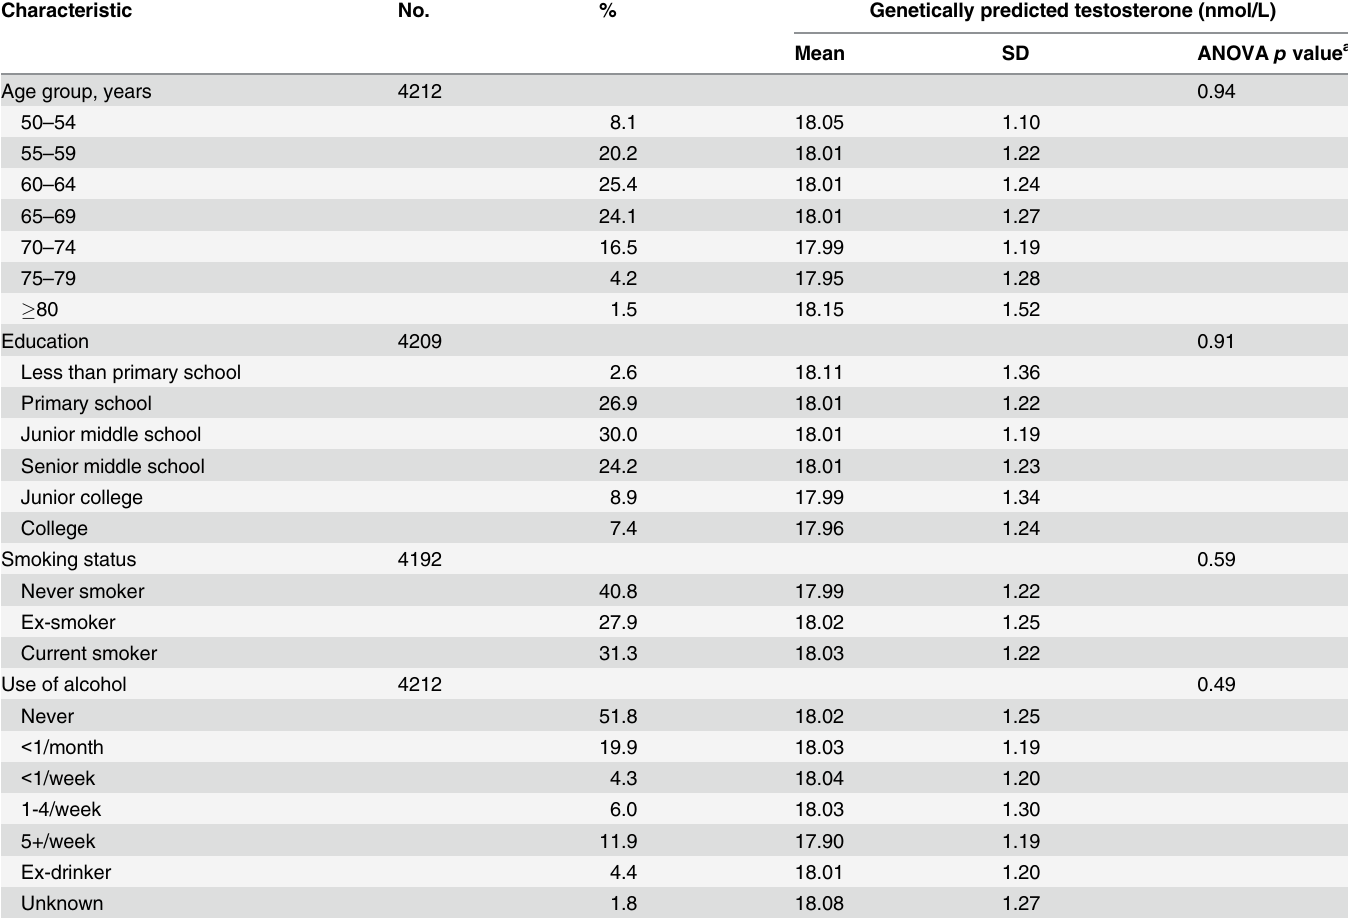
Table 1. Genetically Predicted Testosterone by Socio-demographic Characteristics Among 4,212 Men (50+), Guangzhou Biobank Cohort Study, 2003 – 2008.